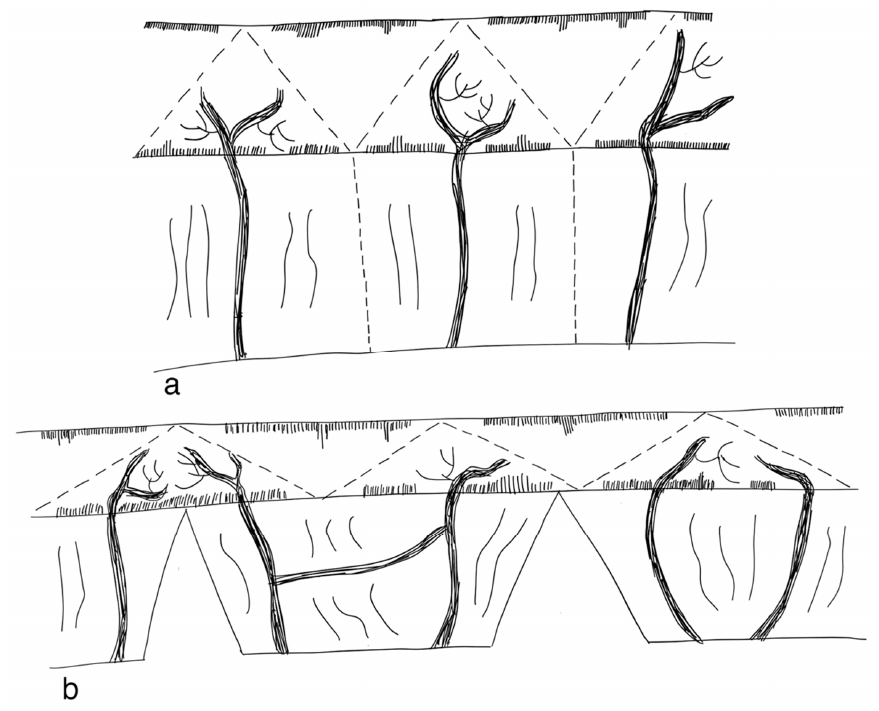
Figure 7. ( a ) The small bowel wall is cut spirally at 45° and 60° to its longitudinal axis. The mesentery is then incised where the previous spiral incision of the bowel met the mesenteric line. ( b ) The small bowel is then stretched longitudinally, twisted and anastomosed. Cserni et al.